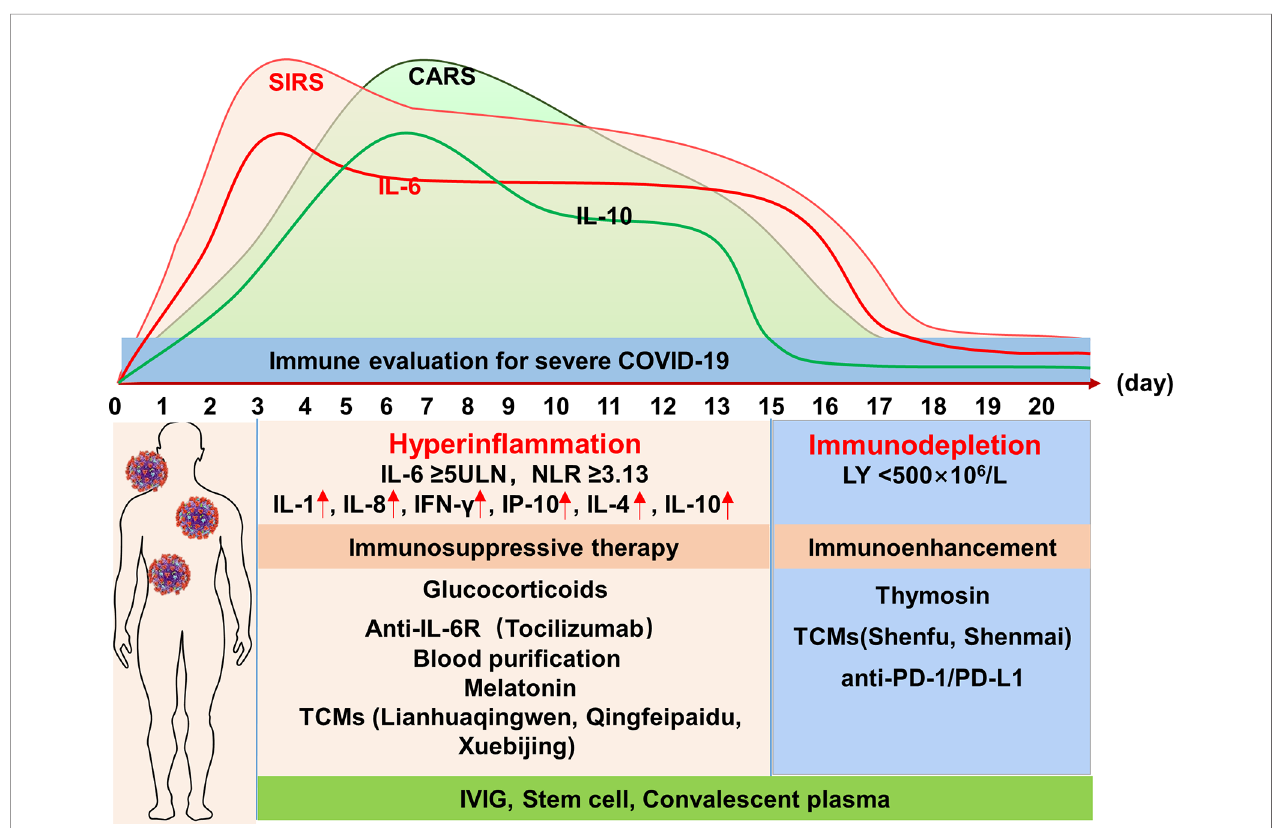
FIGURE 1 | Pro fi le of the immune response of severe COVID-19 and potential immunotherapeutic approaches. IL, interleukin; NLR, neutrophil-to-lymphocyte ratio; LY, lymphocyte; IFN- g , interferon- g ; IP-10, IFN- g -inducible protein-10; TCMs, traditional Chinese medicines; IVIG, intravenous immunoglobulin; PD-1, programmed cell death-1; PD-L1, programmed death ligand